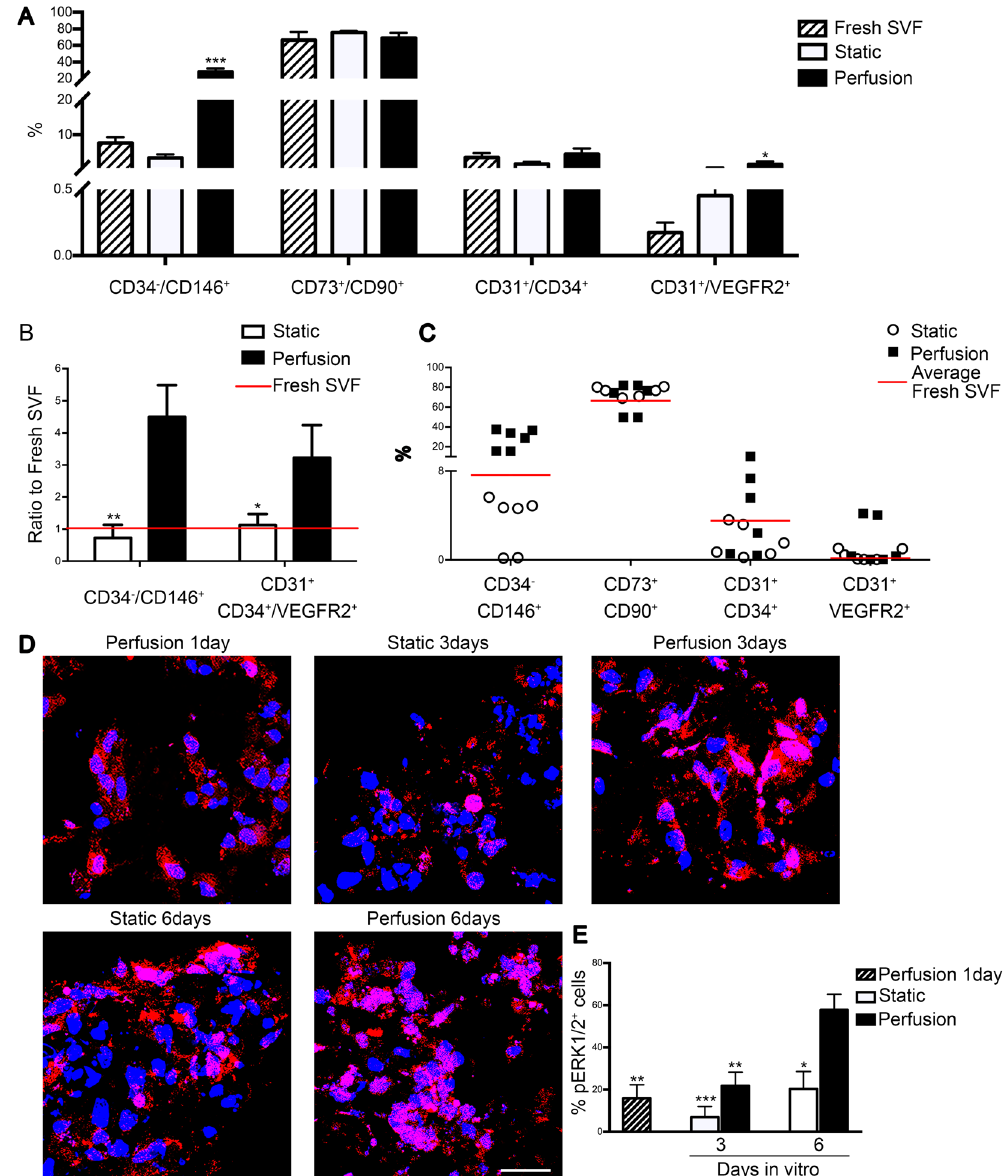
Figure 3. Perfusion enriched the SVF for the vascular cell component. All population presented are considered CD45 − ( A – C ). ( A ) In vitro cell phenotype characterization by 6-channel-flow-cytofluorimetric analysis of freshly isolated (Fresh) or SVF cells following static or perfusion culture. Quantification presented as percentage over the living cells (DAPI + ) of different SVF subpopulations: pericyte (CD34 − CD146 + ), MSC (CD73 + CD90 + ), EC (CD31 + CD34 + ) and mature EC (CD31 + VEGFR2 + ) (n donor = 6). ( B ) Graph representing the ratio of pericytes and EC - progenitor and mature - over the fresh SVF (red line indicates ratio = 1). ( C ) Scatter plot showing the distribution of the 6 donors after static or perfusion culture (red lines indicate the mean). * p < 0.05, ** p < 0.01, *** p < 0.001. ( D ) Representative immunofluorescence images for pERK(1/2) (red). Nuclei were stained with DAPI (blue). Scale bar = 20 μ m. ( E ) Quantification of the pERK(1/2) + cells normalized over the total amount of DAPI. * p < 0.05, ** p < 0.01, *** p < 0.001 (n donor =